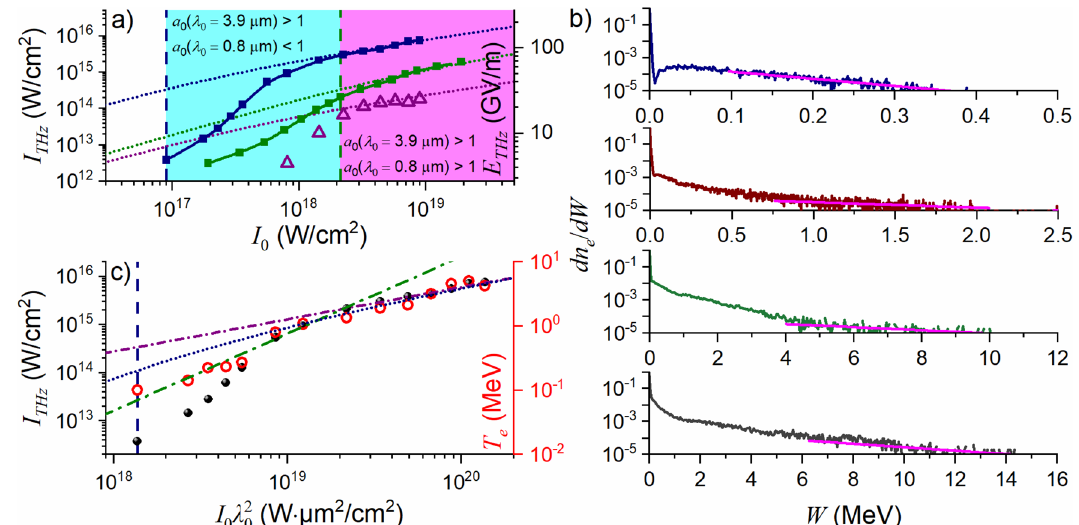
Figure 5. ( a ) The field strength (right axis) and field intensity (left axis) of THz radiation at ξ = 30 λ 0 as a function of the driver field intensity I 0 for a p -polarized (green and blue boxes) and s -polarized (purple triangles) laser driver with τ 0 = 80 fs and λ 0 = 0.8 μm (green circles) and λ 0 = 3.9 μm (blue boxes and purple triangles). Also shown is the ∝ Φ( I 0 λ 0 2 ) scaling, as dictated by the relativistic electron laser ponderomotive potential F e for λ 0 = 0.8 μm (green dotted lines) and λ 0 = 3.9 μm (blue and purple dotted lines). ( b ) Energy distribution function of the recirculating electrons at the moment of time when these electrons reach the y = 0 plasma boundary versus the best Maxwellian fits of their high-energy tails (pink lines) for I 0 λ 0 2 increasing from top to bottom: I 0 λ 0 2 = 1.4 × 10 18 W μm 2 /cm 2 (blue curve), 2.2 × 10 19 W μm 2 /cm 2 (wine curve), 8.8 × 10 19 W μm 2 / cm 2 (green curve), and 1.4 × 10 20 W μm 2 /cm 2 (grey curve). ( c ) The field intensity of THz radiation at ξ = 30 λ 0 (left axis, blue filled circles) and the temperature of CTR-emitting electrons T e (right axis, red open circles) as a function of I 0 λ 0 2 . Also shown are the ∝ Φ( I 0 λ 0 2 ) scaling (blue dotted line) and the best ( I 0 λ 0 2 ) α fit for T e ( I 0 λ 0 2 ) with α = 1.2 (green dash–dotted line) and 1/2 (purple dash–dotted line). Shown by dashed vertical lines are the driver intensities I 0 ( a ) and the I 0 λ 0 2 product ( c ) corresponding to a 0 = 1. Simulations are performed for a laser driver with two central wavelengths ( λ 0 = 0.8 and 3.9 μm), a pulse width τ 0 = 80 fs, and a beam-waist diameter d 0 = 4 λ 0 . The laser slab has an initial electron density n 0 = 4 n c , a width l x = 16 λ 0 , and a depth l y = 4 λ 0 target with l y = 4 λ 0 , the CTR waves are separated by Δ r ≈ 17.5 λ 0 , giving rise to fringes with Δ ν ≈ 4.4 THz in the spectrum of THz radiation (Fig. 3c). As l